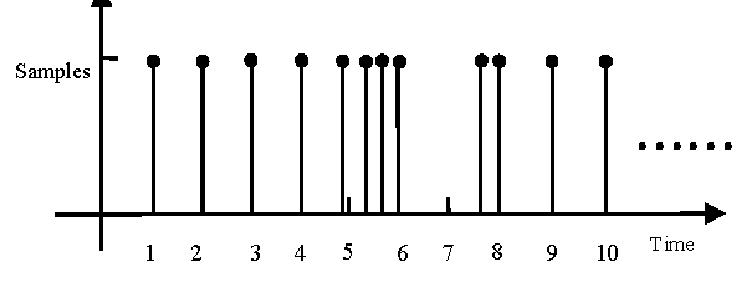
Figure 1. Illustration of non-uniform sampling.